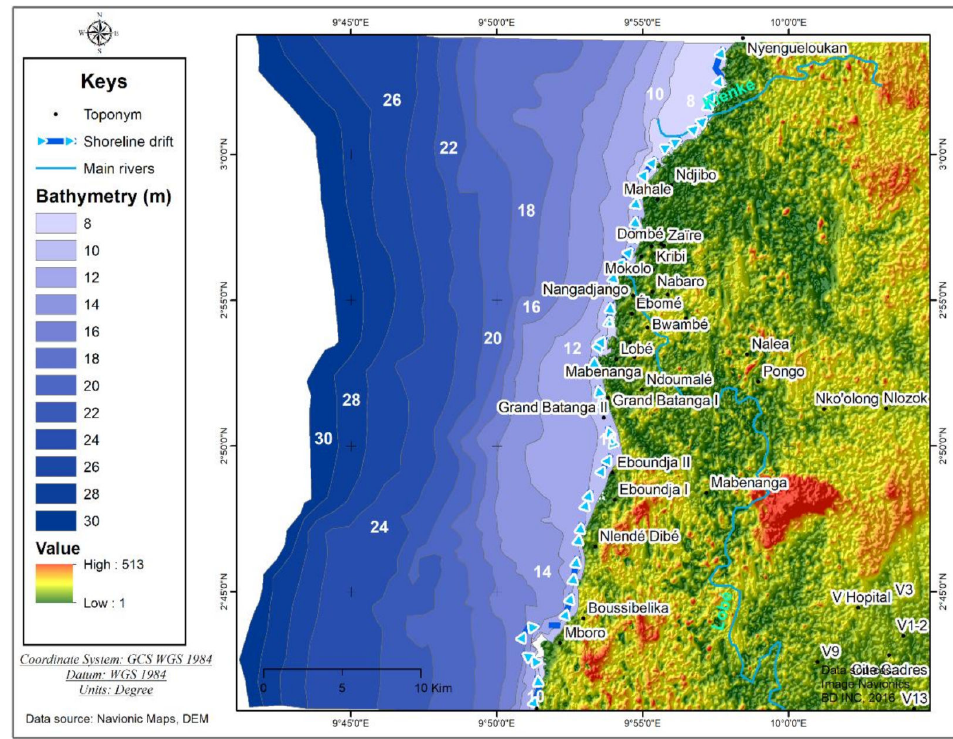
Figure 12. Bathymetric configuration of the Kribi coastline (Source: DEM and digitized navionic bathymetric map).